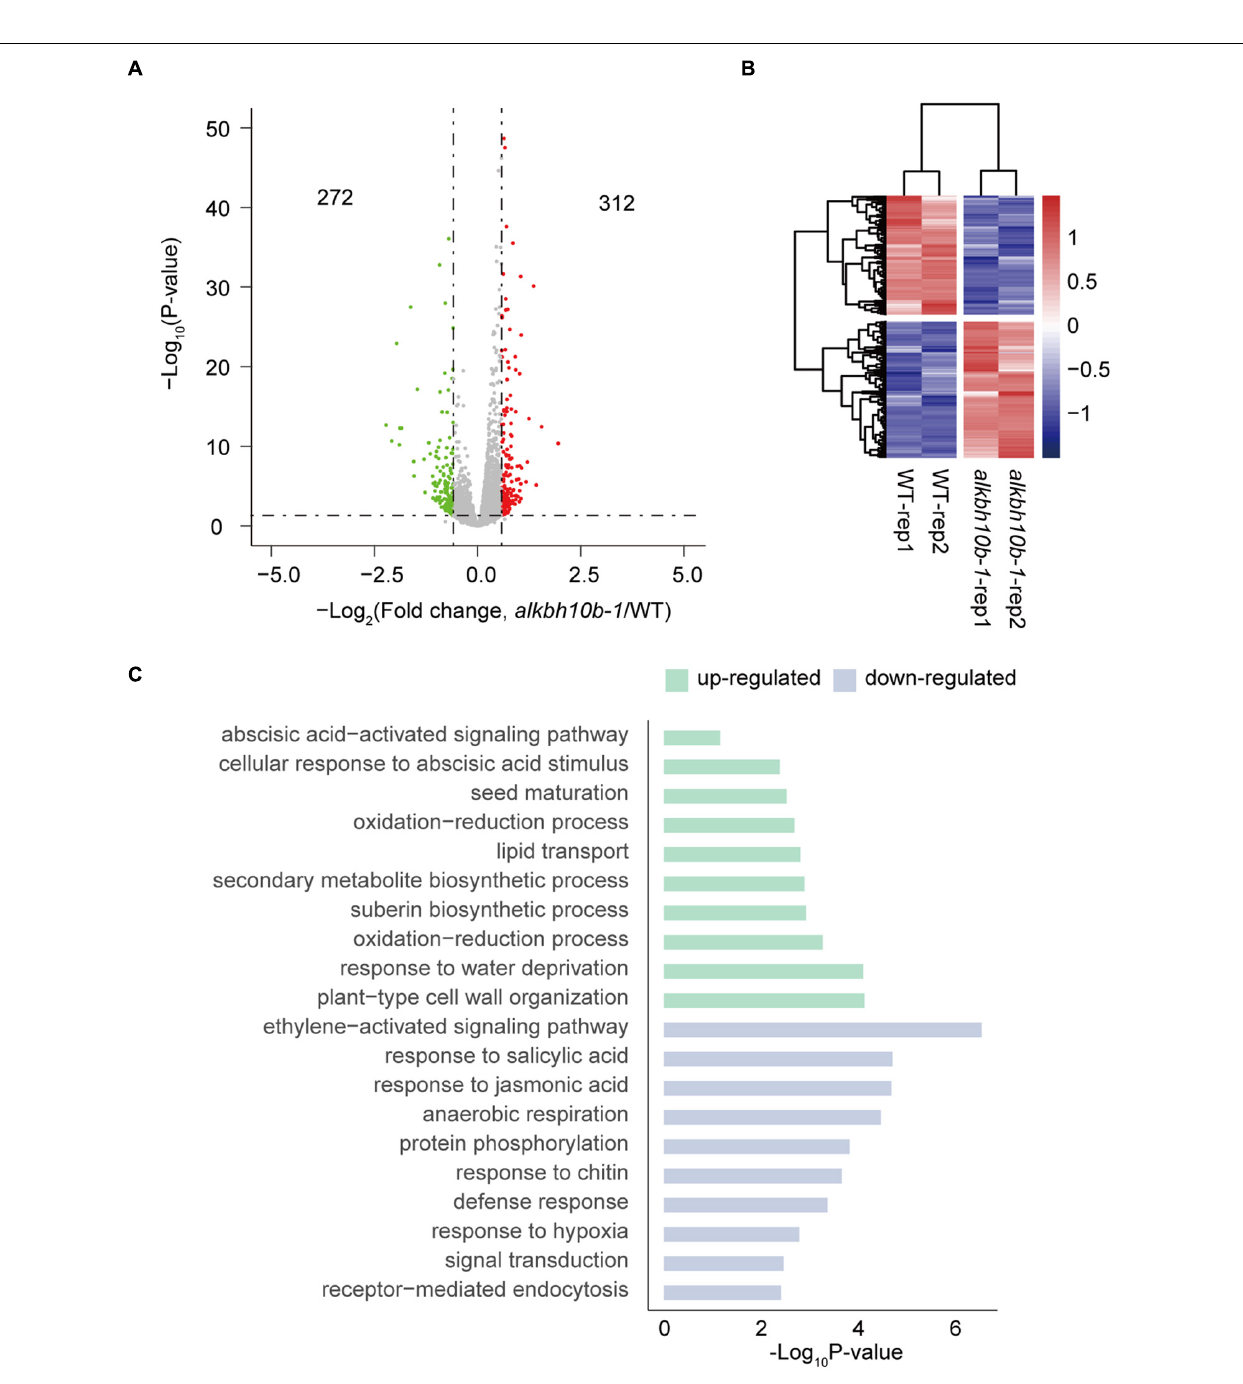
FIGURE 4 | Differential expression genes identified in alkbh10b-1 compared with Col-0. (A) Volcano plots showing the differentially expressed genes identified in alkbh10b-1 . (B) Heatmap plots showing the normalized RPKM of differentially expressed genes in alkbh10b-1 . (C) Biological process enrichment analysis of the upregulated and downregulated genes in alkbh10b-1